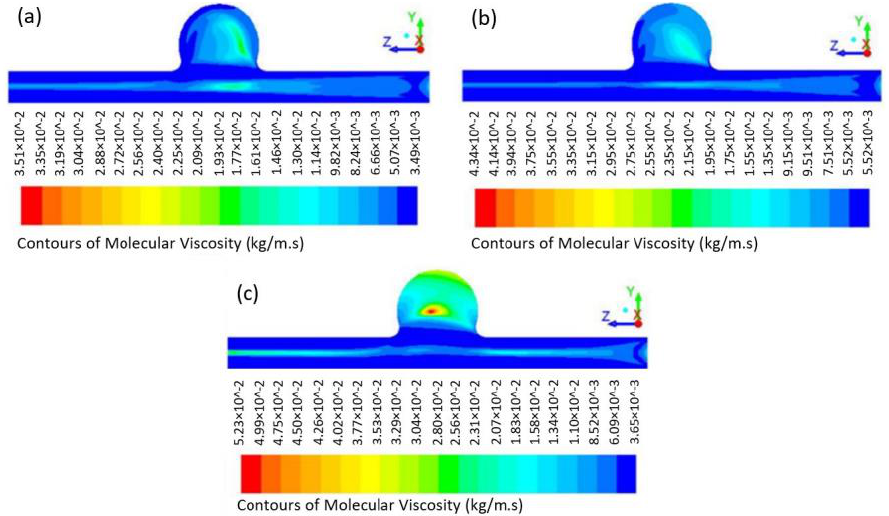
Figure 10. Viscosity in the central plane (x = 0) for non-Newtonian flows and distinct velocities. ( a ) u = 888 mm/s; ( b ) u = 444 mm/s; ( c ) u = 88.8